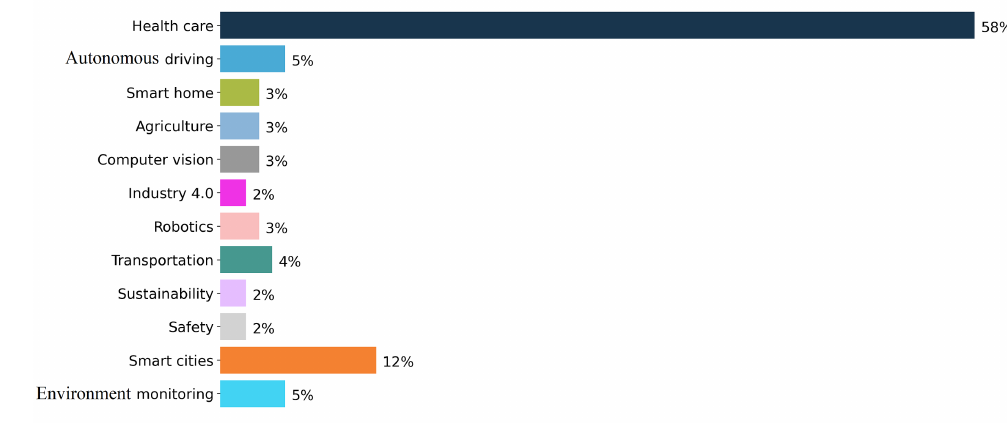
Figure 13. Percentage of papers of sample studies per domain of applications. The most popular category is healthcare followed by smart cities, autonomous driving, environment monitoring and transportation